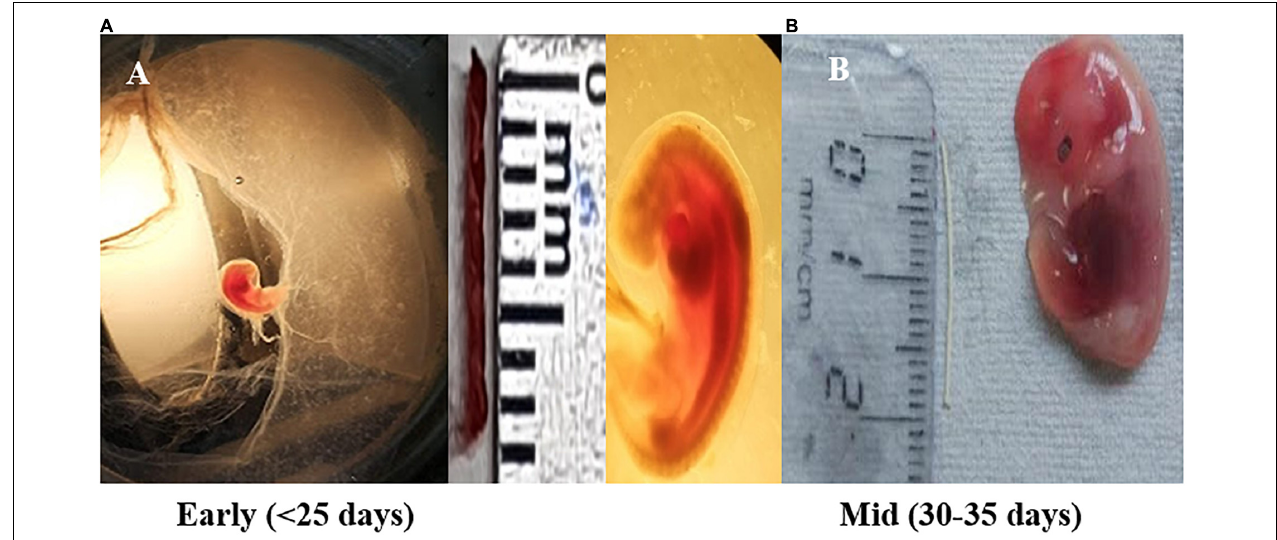
FIGURE 1 | Fetal size depicting early pregnancy and mid-pregnancy (shown in scale, cm). (A) Fetus measure between 0.8 and 1.1 cm in length (crown rump length) corresponds to Day < 25 of gestation (early stage) and shows the formation of the heart and primitive intestine. (B) Embryo having length of 1.6–2.0 cm (crown rump length) corresponds to Day ± 31–35 days of gestation (mid-stage). During this, the development of external ear takes place along with the tail representing, one-fourth of the total length of the